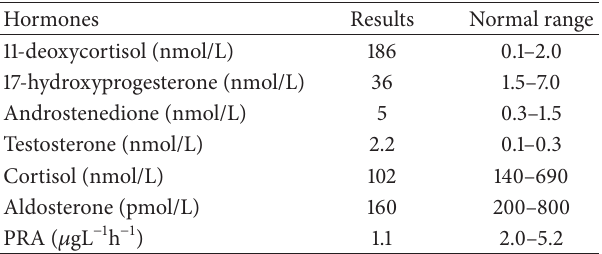
Table 1: Hormonal analyses of Patient